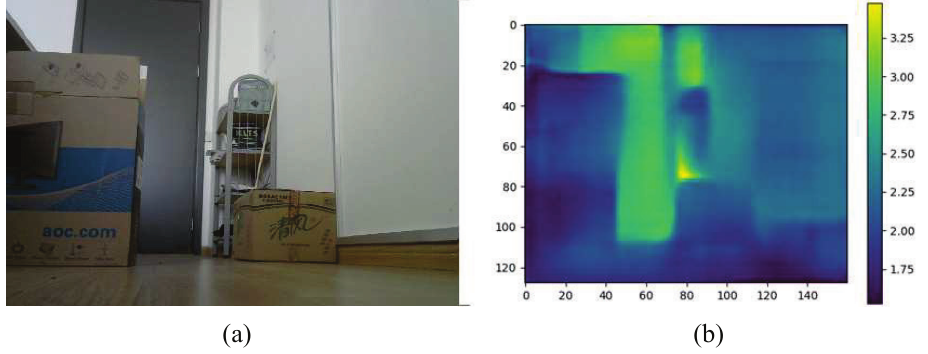
Figure 6. Indoor environment with its depth information; ( a ) Original scene image, ( b ) Depth